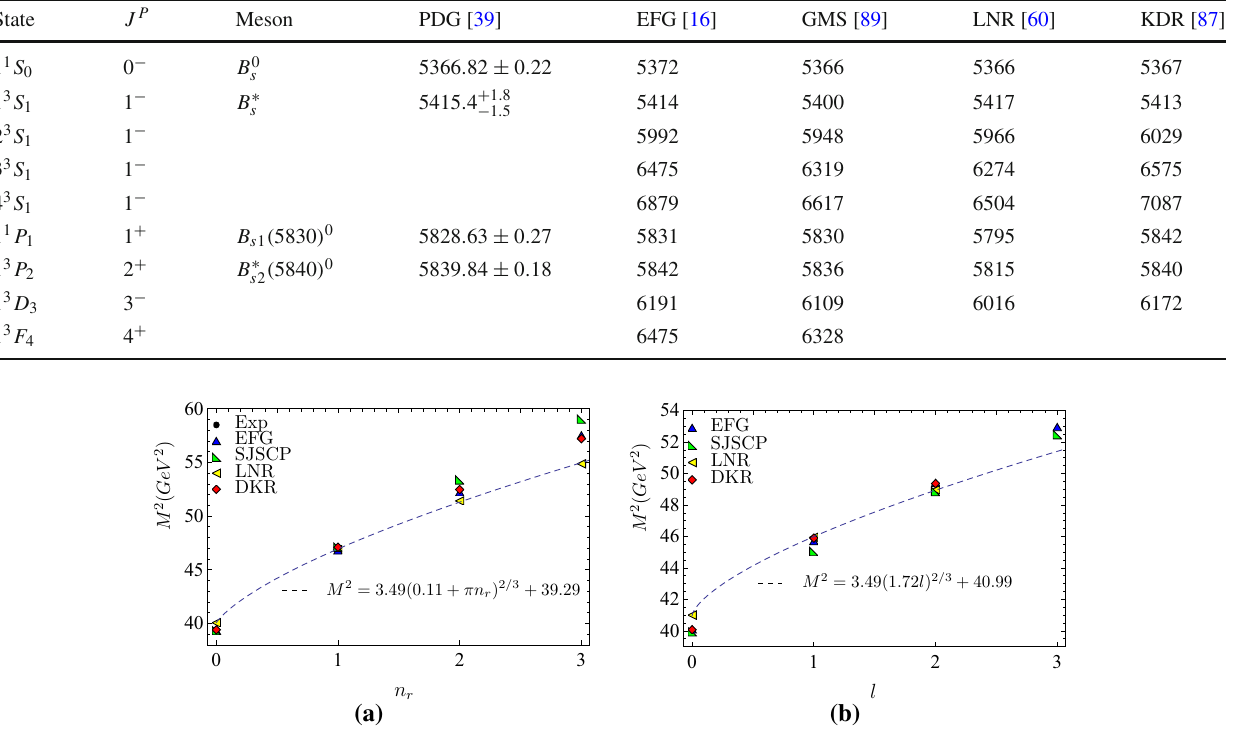
Table 5 Masses of the bottom mesons (in MeV). The experimental data are from PDG [39]. The theoretical values are from EFG [16], GMS [89], LNR [60] and KDR [87]. ? denotes the possible candidates for the unwell-established states or the mesons needing confirmation